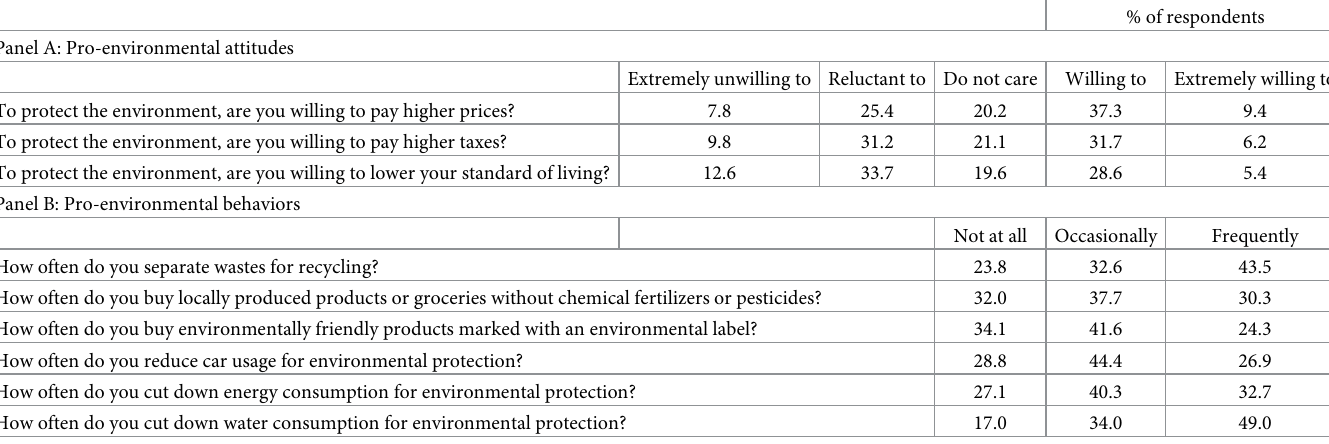
Table 1. Summary of pro-environmental attitudes and behaviors.